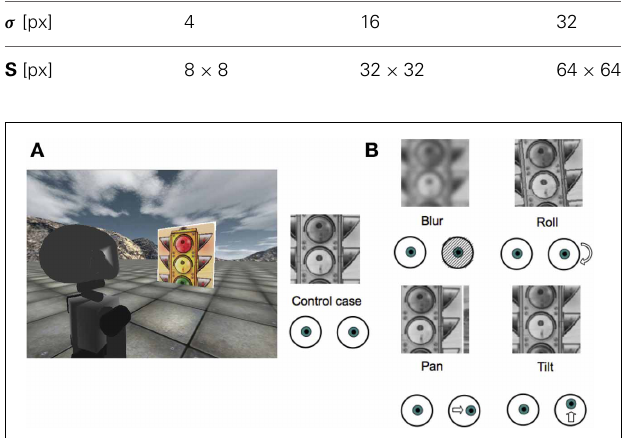
Table 1 | Parameters of the different blur levels.